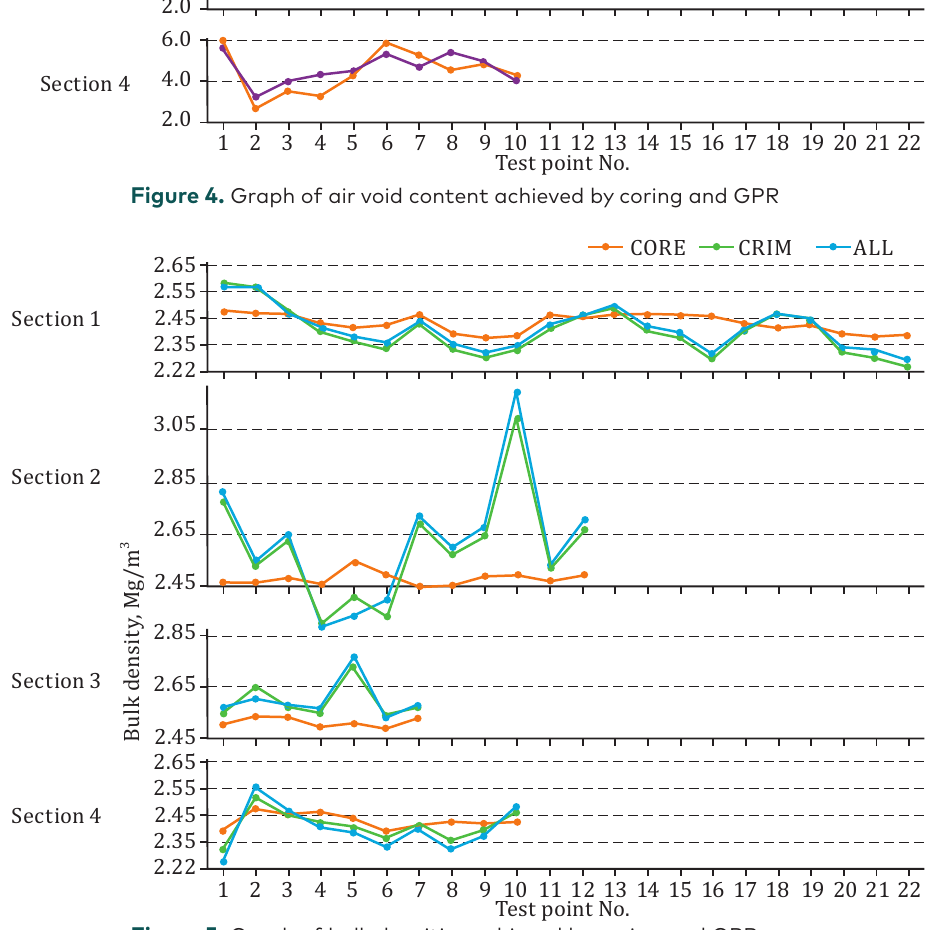
Figure 5. Graph of bulk densities achieved by coring and